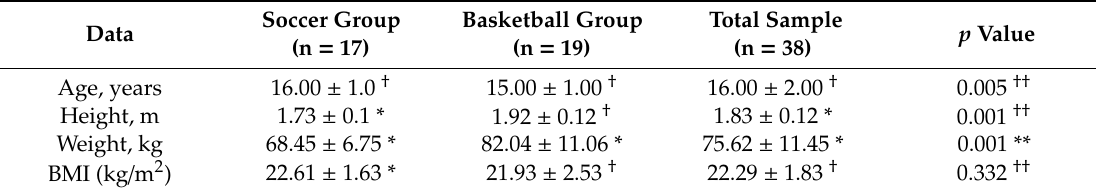
Table 1. Sociodemographic data of the